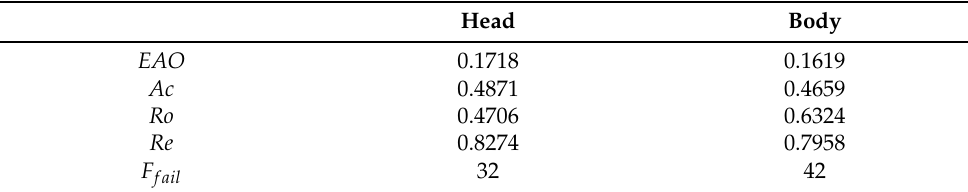
Table 9. Comparison of performance evaluations for both regions of